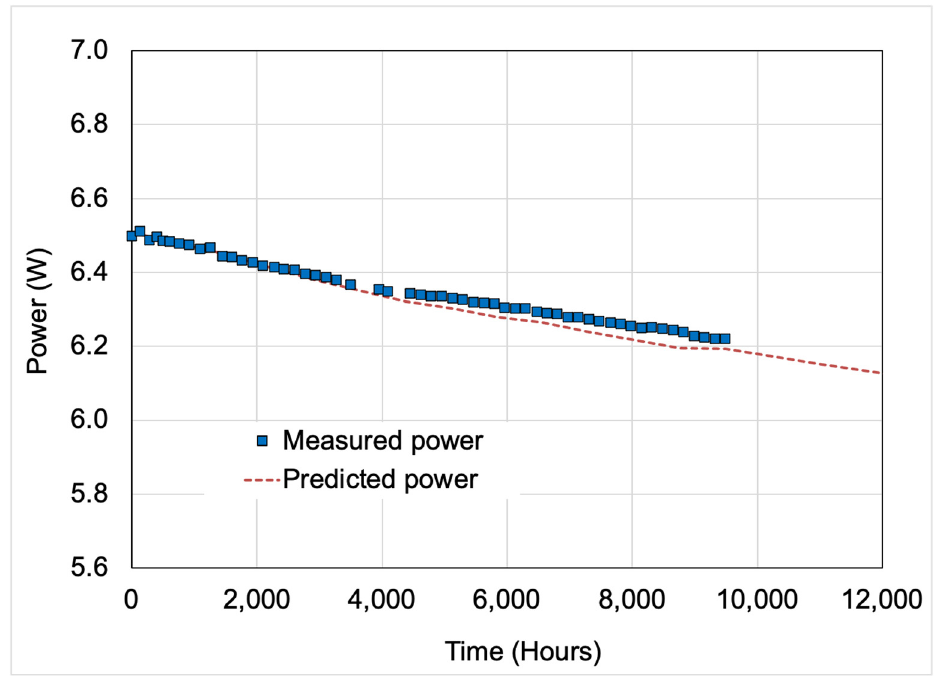
Figure 12. Measured and predicted power values for the SKD 48-couple module are in excellent agreement.